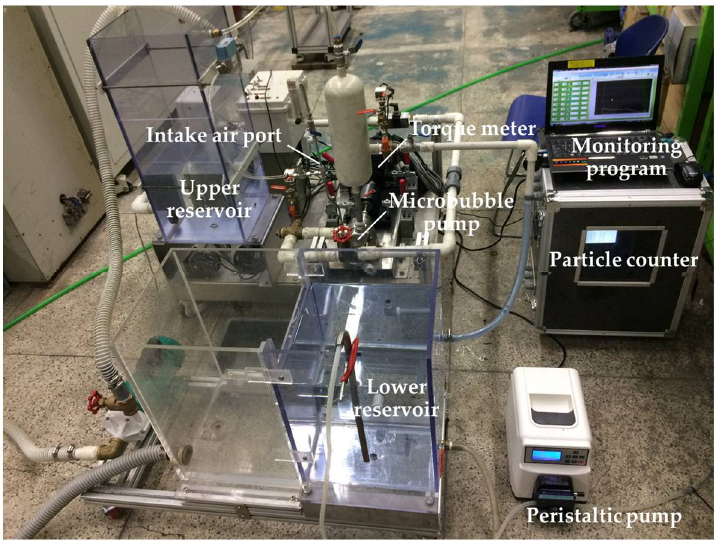
Figure 3. Picture of a microbubble pump experimental apparatus.